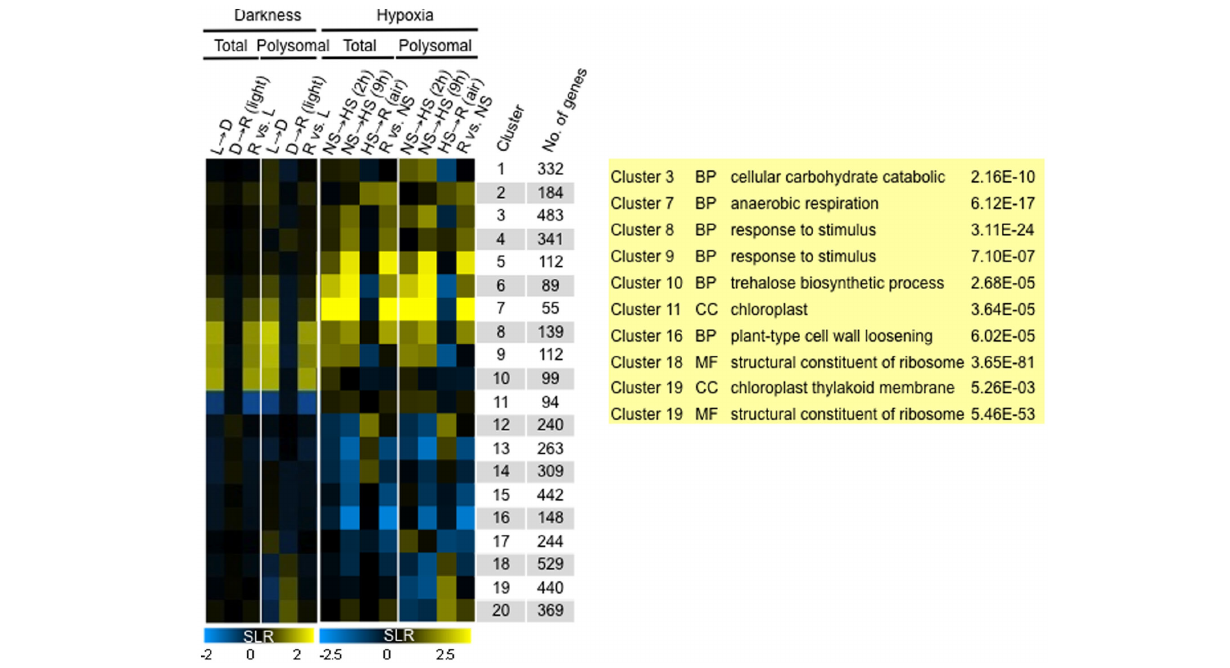
FIGURE 9 | Comparison of change in transcriptome and translatome mRNA abundance in response to light and oxygen availability. Fuzzy k -mean clustering analysis performed on 14 mean signal log ratio (SLR) comparisons of total and immunopurified polysomal mRNA transcript abundance. Genes included in the analysis were those without all “absent” calls in bioreplicates and significantly different increase or decrease in abundance (|SLR| ≥ 1; FDR < 0.01; n = 5024 probe pair sets;Table S2A in Supplementary Material).The heatmap shows median SLR values for each of